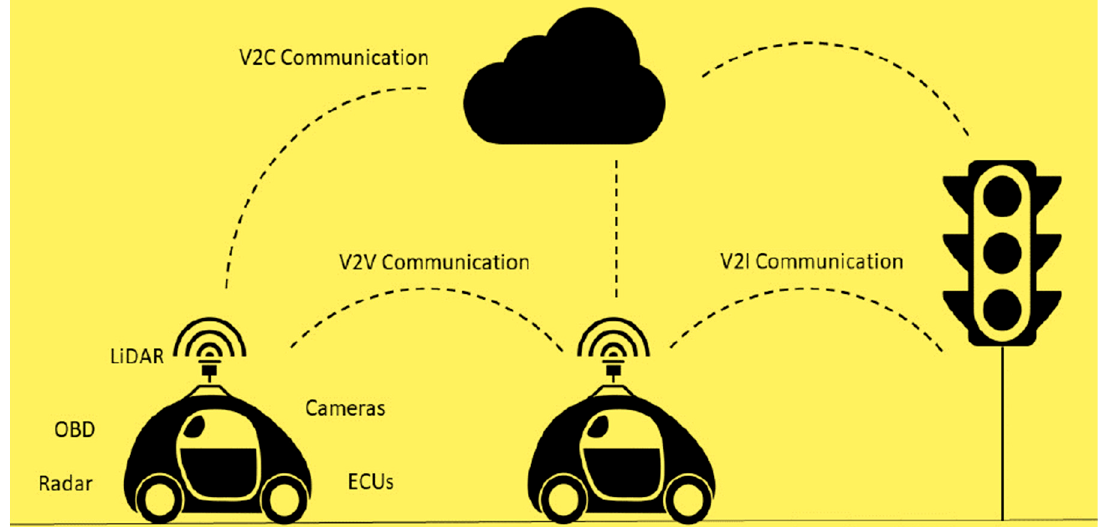
Figure 3. Attack points through communication.